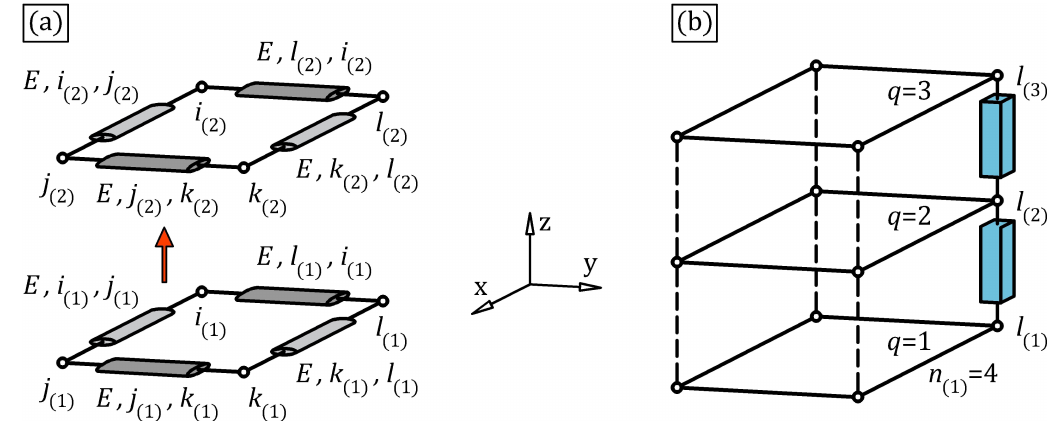
Figure 6: Diagram of generating beam elements. (a) R modeling roving sections, (b) P modelling the matrix between the